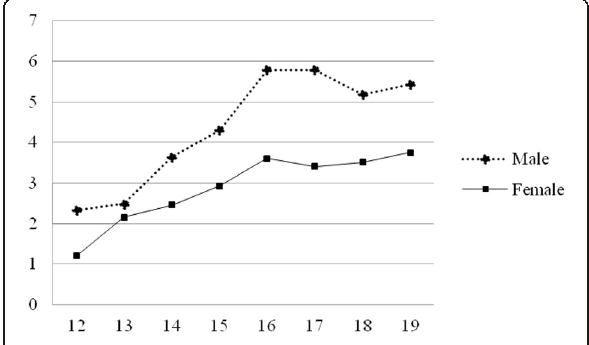
Fig. 2 Mean of the variety deviance score for each age-cohort, separated by